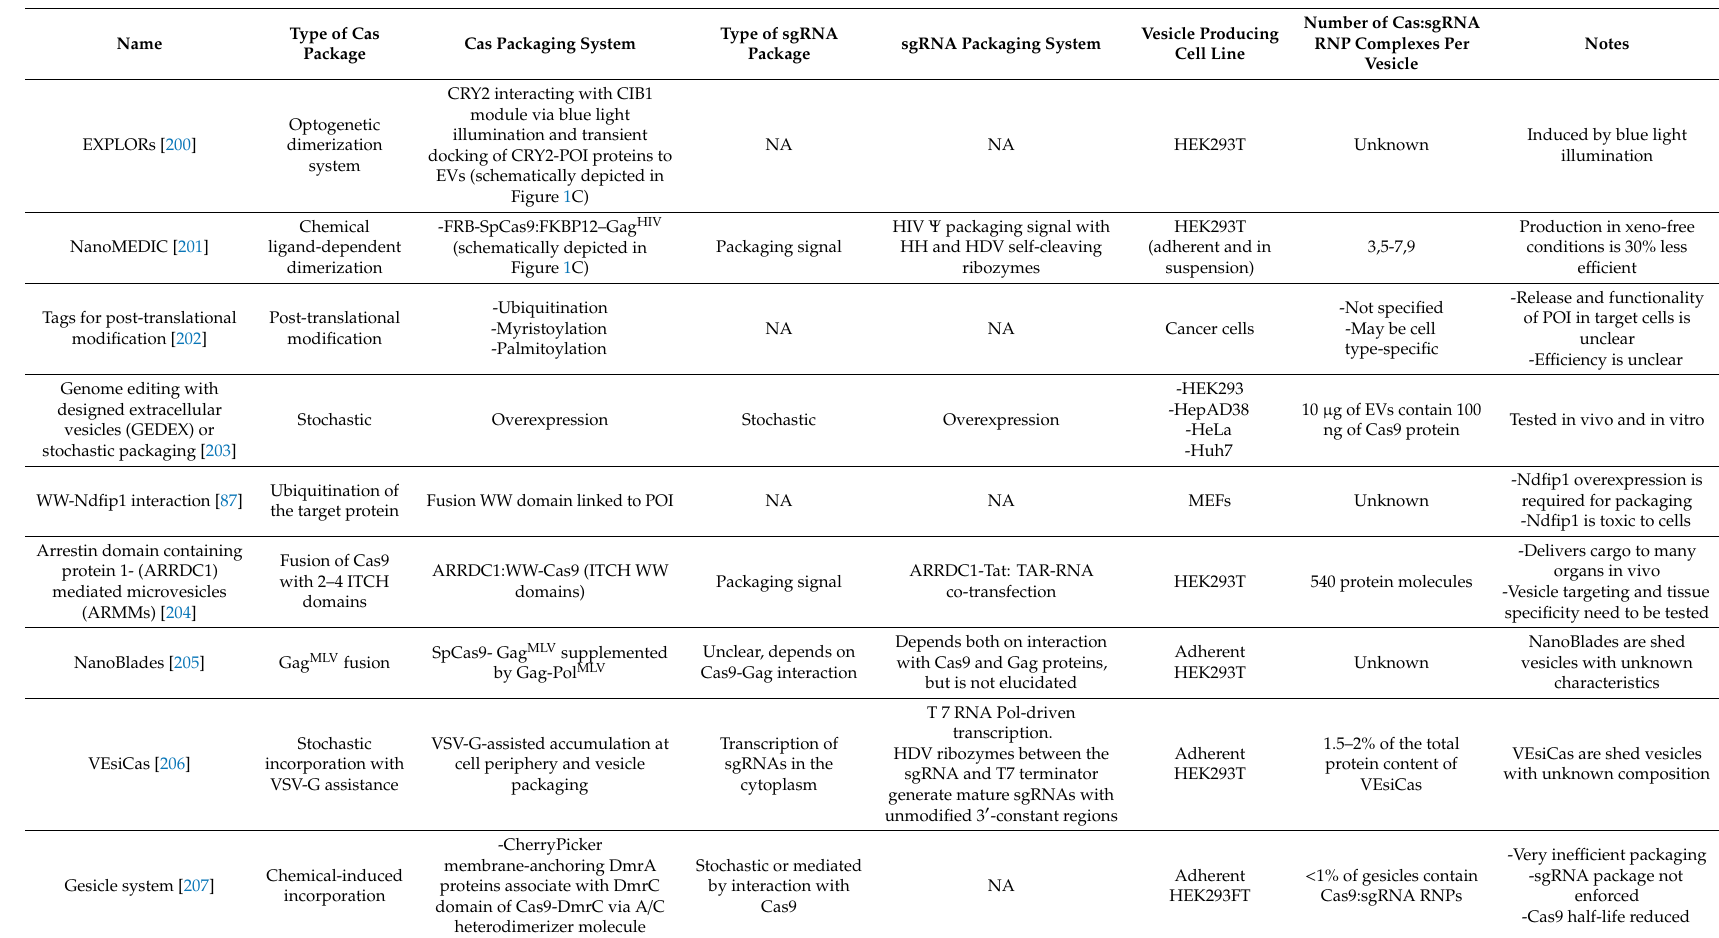
Table 1. Molecular tools and mechanisms for packaging Cas proteins into